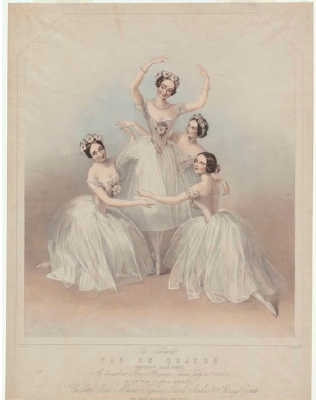
Figure 1. Poster for Concert.